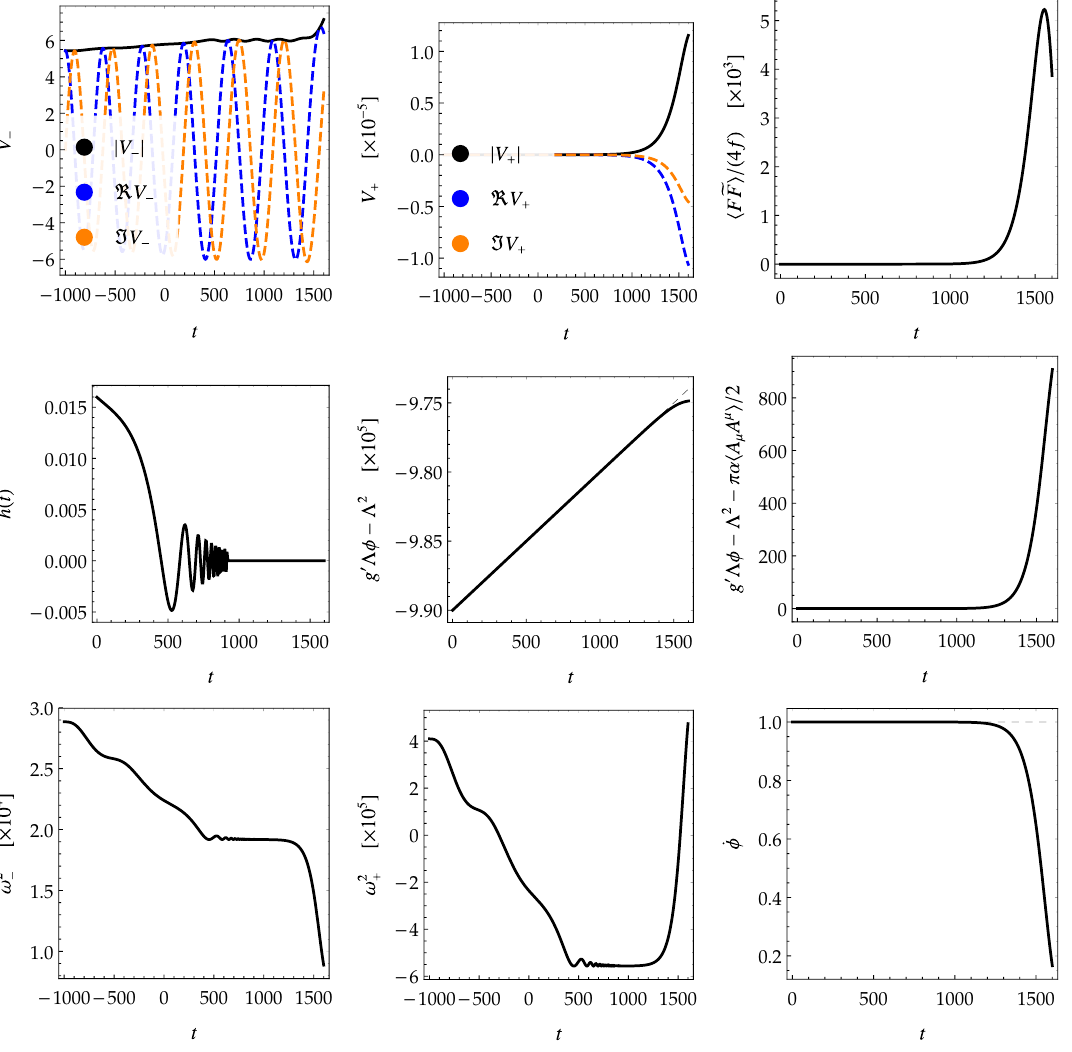
Figure 16 . Solutions of the system of equations (3.11), (3.12), (3.13) (which does not include thermalisation e(cid:11)ects). While time scales will be di(cid:11)erent, we expect similar qualitative features when the e(cid:11)ect of temperature is taken into account. All quantities are expressed in units of